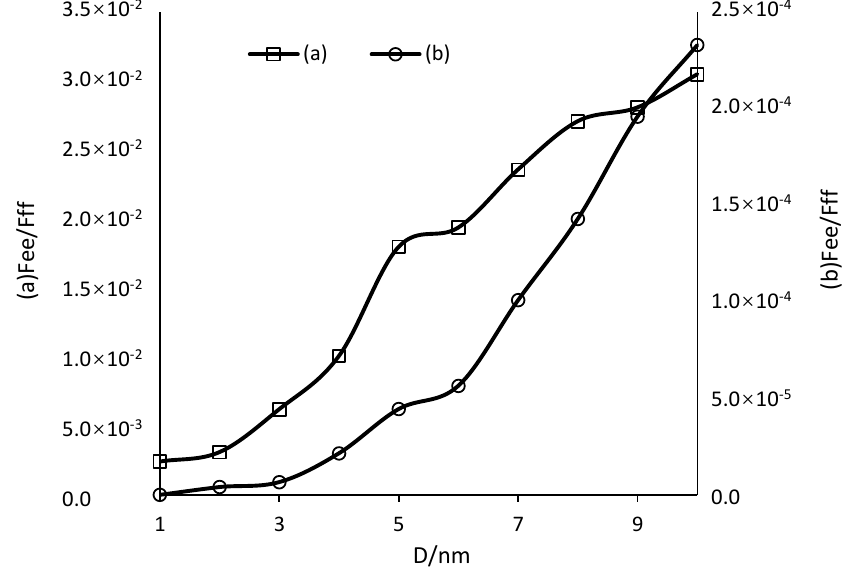
Figure 12. Comparison of the calculated force of edge-edge and face-face